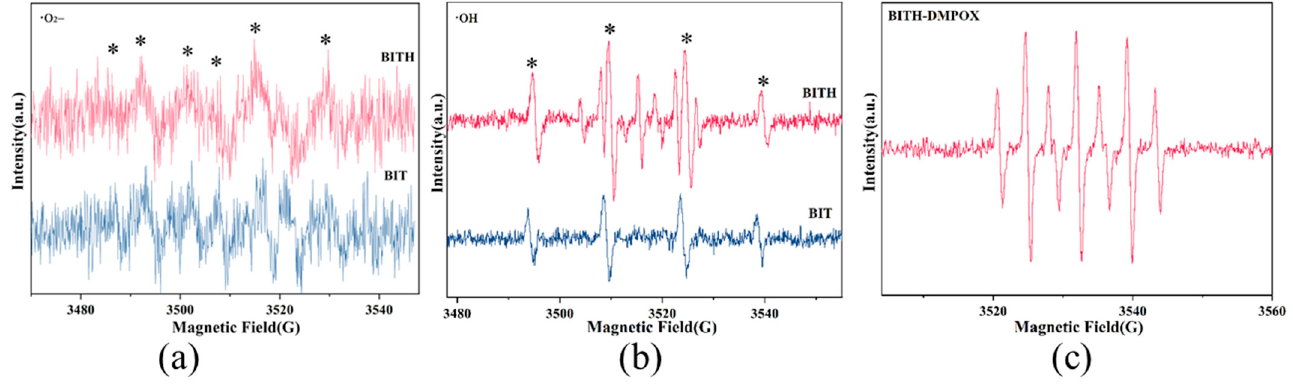
Figure 5. EPR patterns of ( a ) O 2 − radical, ( b ) OH radical over BITH and BIT, and ( c ) DMPOX over BITH.